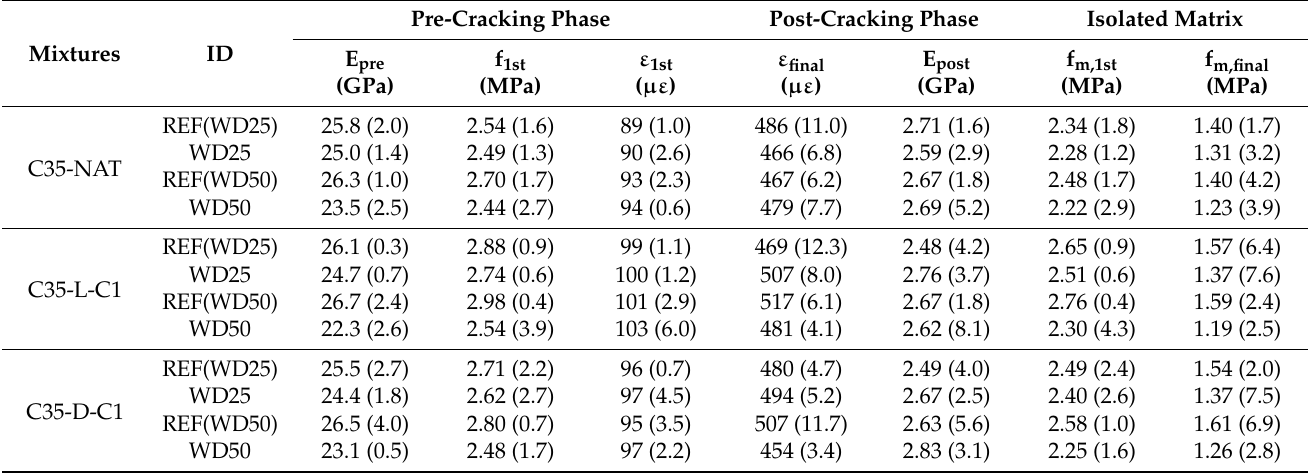
Table 4. Main representative parameters for tested reinforced elements subjected to wet-dry cycles.